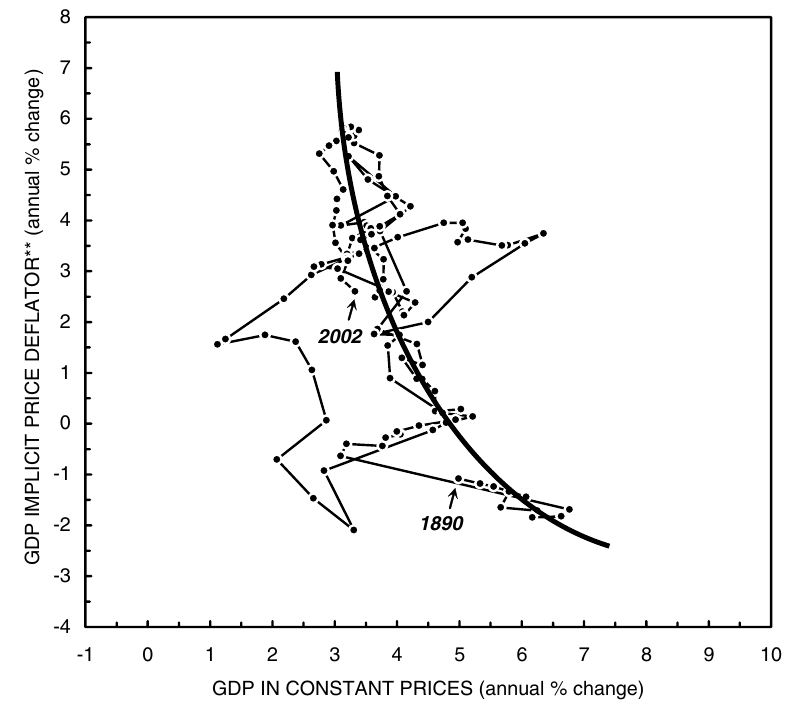
Figure 6 – United States: Long Term Inflation and